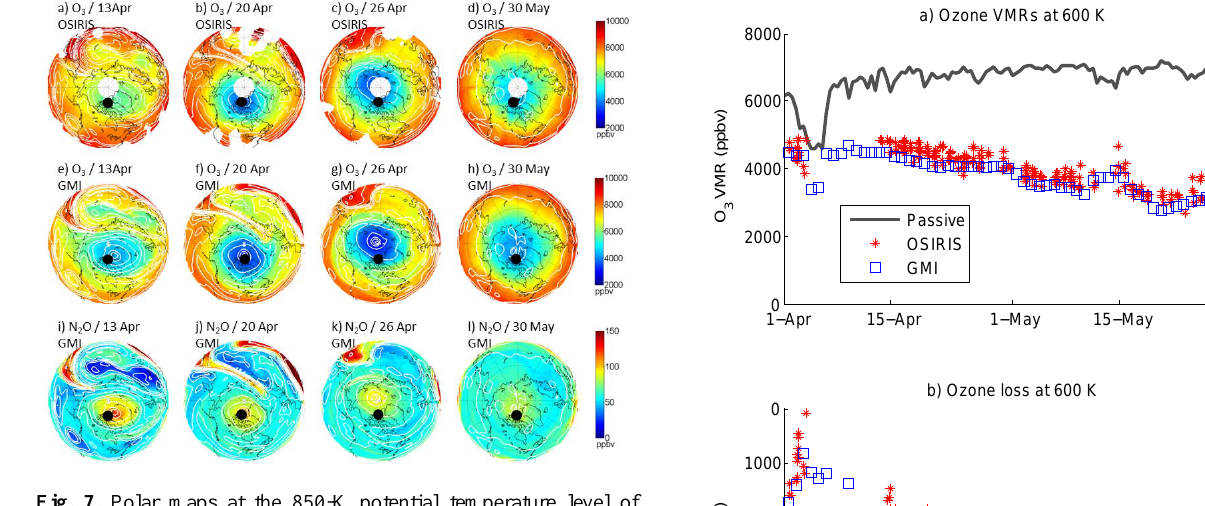
Fig. 7. Polar maps at the 850-K potential temperature level of OSIRIS ozone (top row), GMI ozone (middle row), and GMI N 2 O (bottom row) VMRs given in ppbv for 13, 20, 26 April and 30 May 2011. Low [high] VMRs are given in blue [red]. White lines indi- cate PV contours. Eureka is indicated by the black circle.